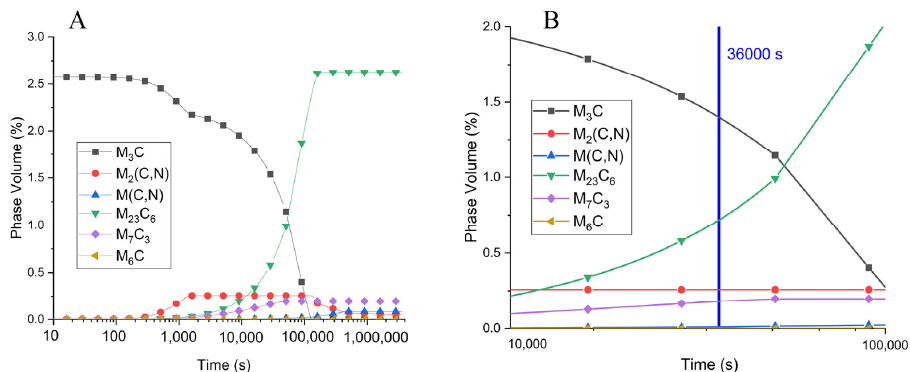
Figure 10. Results of the simulation of carbides precipitation during Quenching at 890 ◦ C and Temping at 590 ◦ C for S690 steel performed with JMatPro ® software; overview ( A ) and close up of the region near 10 h treatment time ( B ).